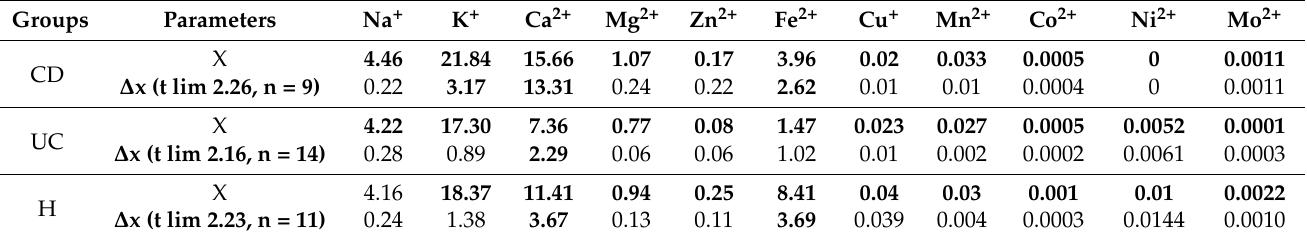
Table 2. Significance of the mean values of the metal concentrations in the cytoplasm of SRB from patients with IBD. Groups Parameters